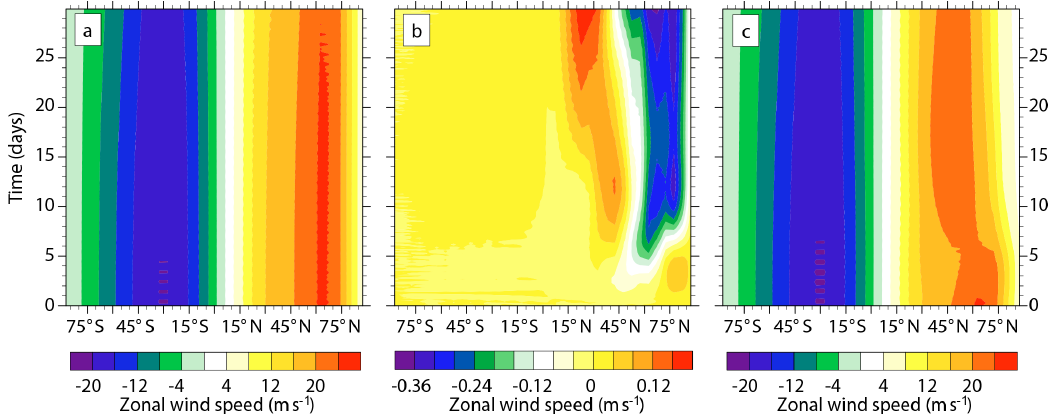
Figure 3. Hovmöller diagram of the zonal-mean zonal wind for the reference simulation (a) , the zonal-mean zonal wind difference with Box0.1 (b) and the zonal-mean zonal wind for the 10box simulation at the 6 . 25hPa level.